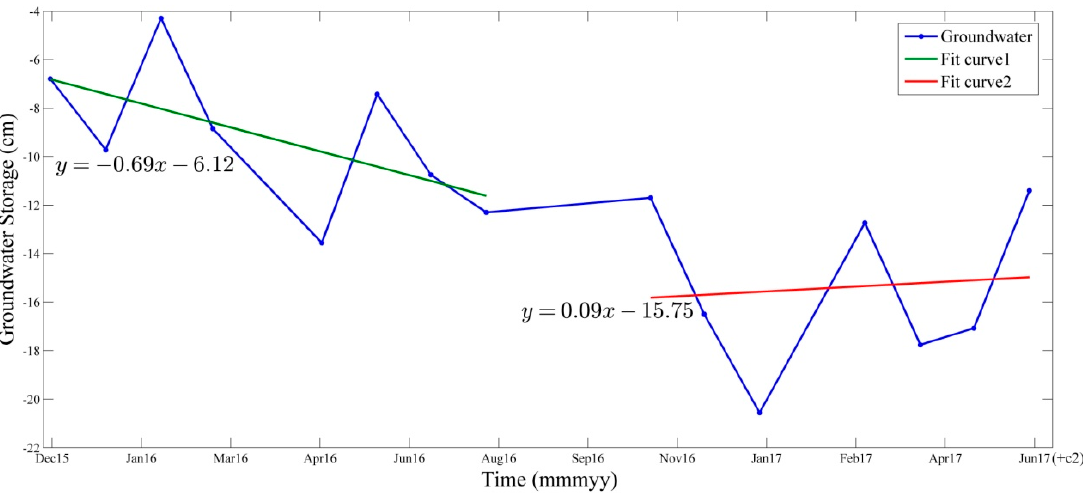
Figure 10. Variation in groundwater storage from December 2015 to June 2017. Remote Sens. 2018 , 10 , x FOR PEER REVIEW